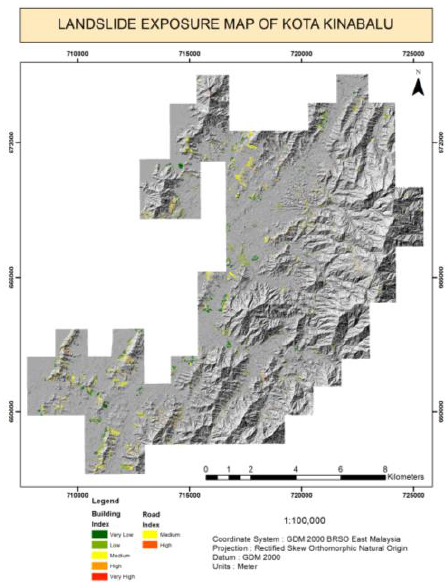
Figure 7. Landslide Exposure map of Kota Kinabalu